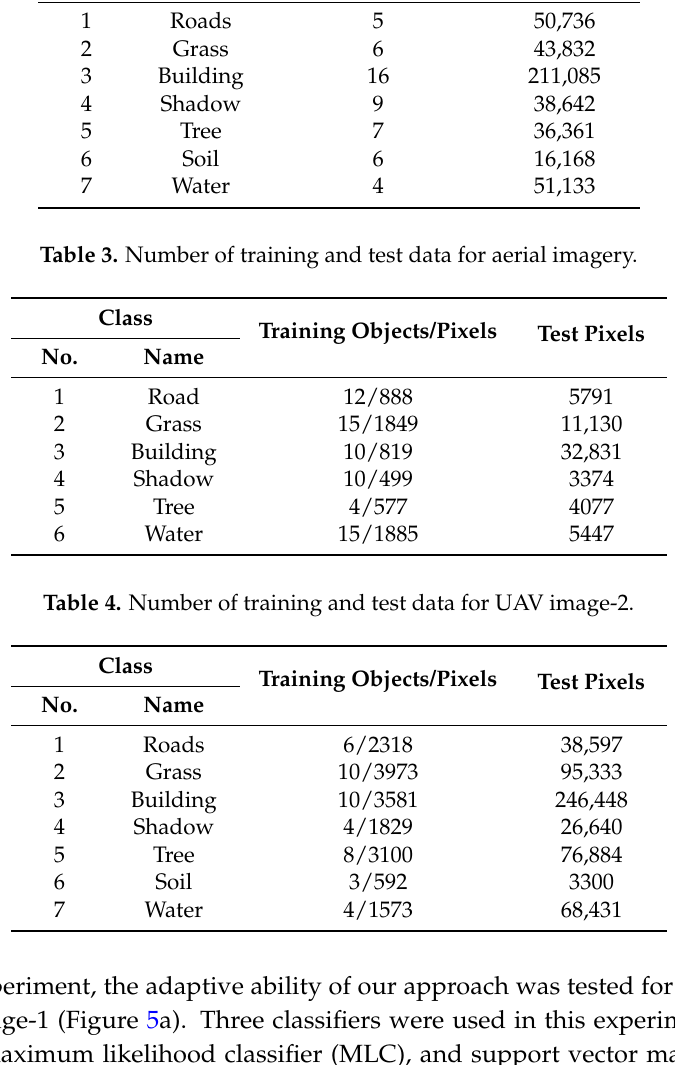
Table 2. Number of training and test data for unmanned aerial vehicle (UAV) image-1.